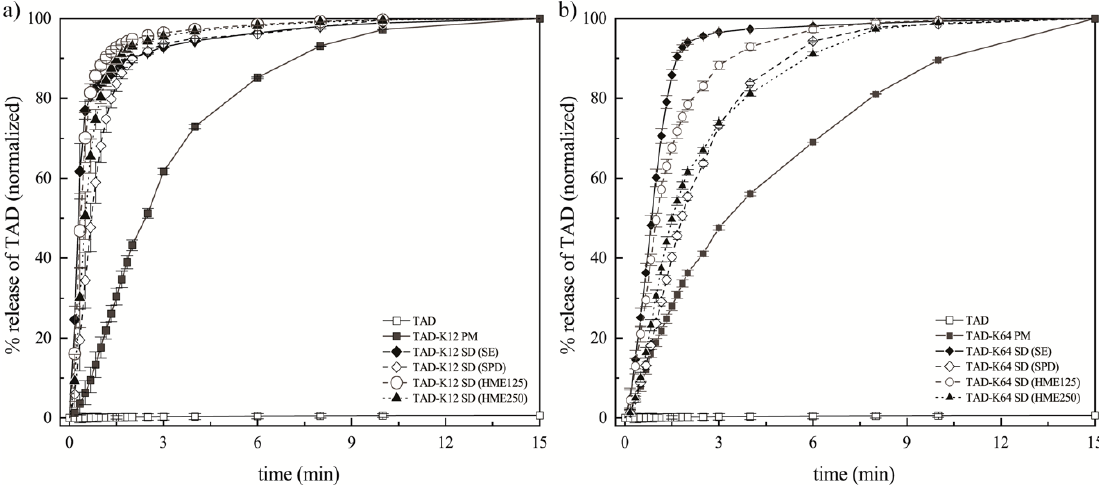
Figure 10. Release profiles of TAD from PMs and SDs prepared by different methods: ( a ) K12 groups and ( b ) K64 groups.